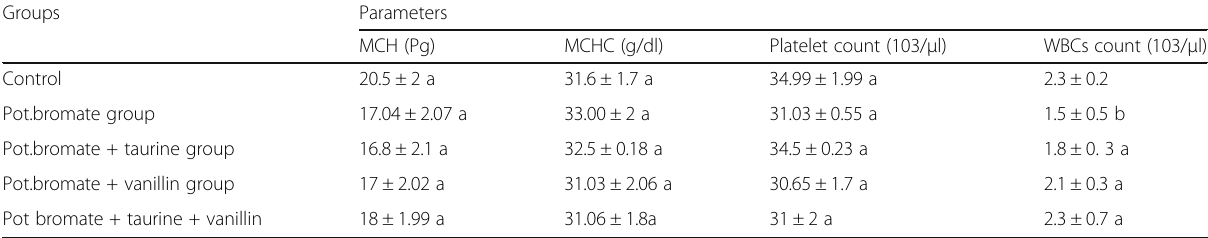
Table 6 Effect of taurine and/or vanillin on MCH, MCHC values, platelet, and WBCs counts in the potassium bromate-treated rats Groups